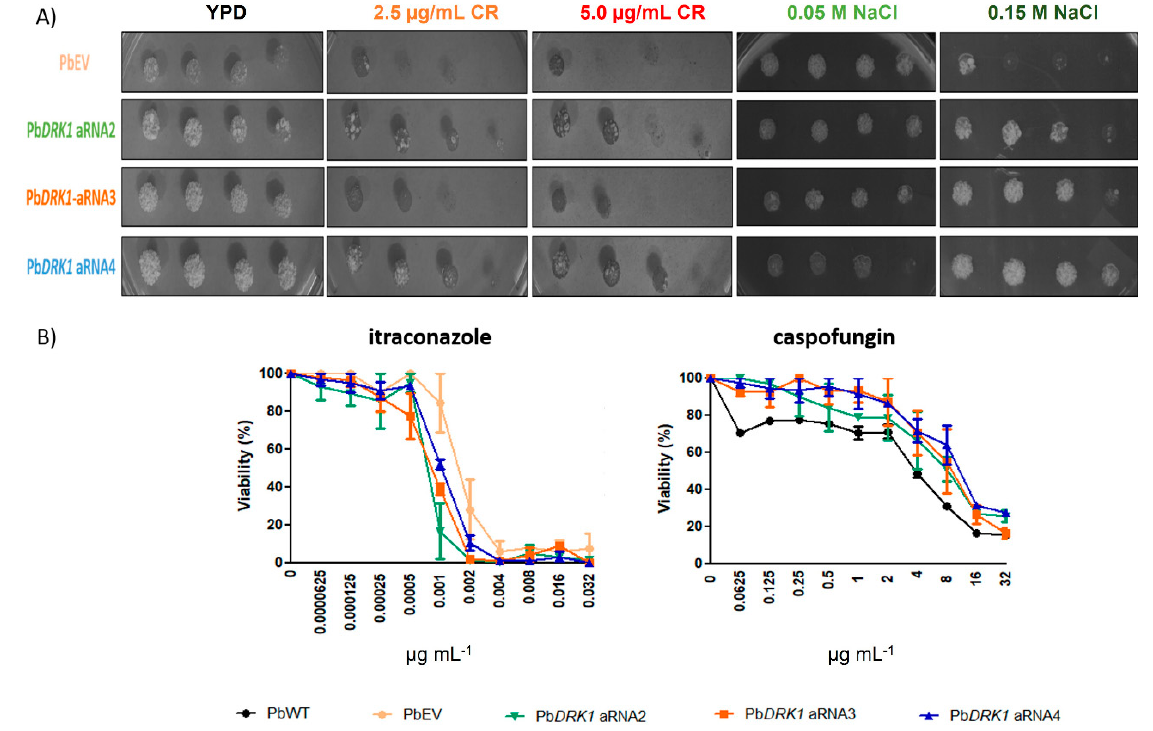
Figure 10. DRK1 down expression resulted in altered sensibility to osmotic, cell wall stressors, and antifungals. ( A ) Pb DRK1 aRNA strains are more tolerant to the cell wall and osmotic stress. Ten-fold dilutions of cells were spotted onto YPD agar plates with the indicated concentrations of Congo red (CR) and NaCl. Plates were incubated at 37 °C for 7 days before being photographed. ( B ) DRK1 depletion leads to altered sensibility to itraconazole and caspofungin dose-response curves of antifungals against PbWT, PbEV, and Pb DRK1 aRNA strains.